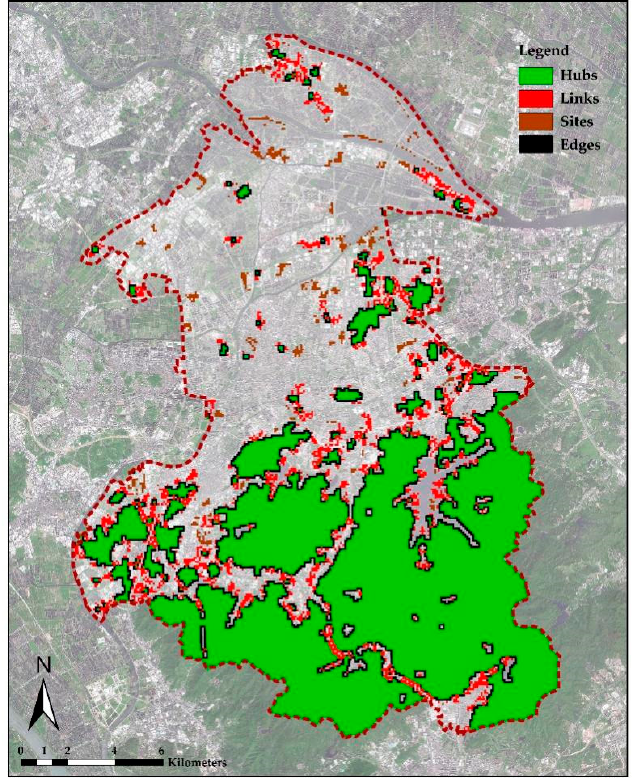
Figure 9. UGI spatial pattern components.